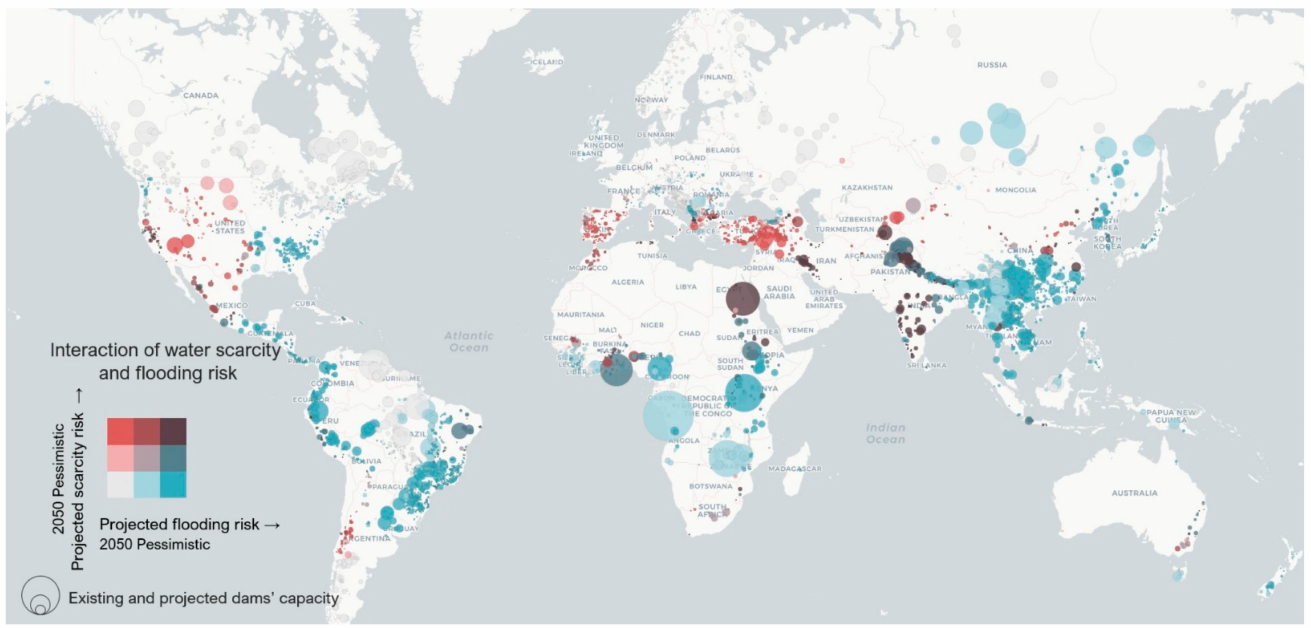
Figure 12. All hydropower dams in this study (existing and projected) with color indicating the combined projected risks of water scarcity and floods by 2050, under a pessimistic scenario, using the same color pattern as Figure 11. The size of circles indicates the hydropower capacity of the dam. See the interactive version of this map at https://rcamargo.shinyapps.io/HydropowerClimateChange; (accessed 21 January